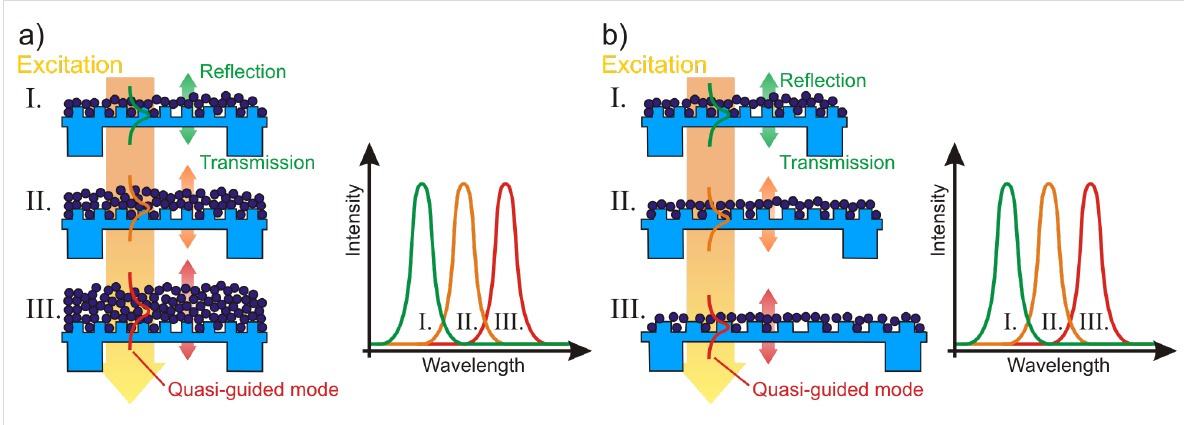
Figure 1: A 60 µm thick polydimethylsiloxane (PDMS) membrane with a 400 nm period and 140 nm deep linear grating nanostructure is coated with a high-refractive index layer of titanium dioxide (TiO 2 ) nanoparticles. Resonances are observed in the normal-incidence transmission spectrum be- tween crossed-polarization filters. The resonance shift is investigated as a function of a) the nanoparticle layer thickness and b) strain. (Structure dimensions not to